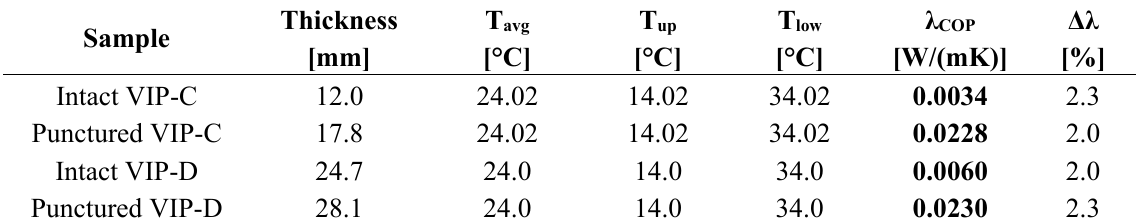
Table 2. Effect of vacuum loss on punctured